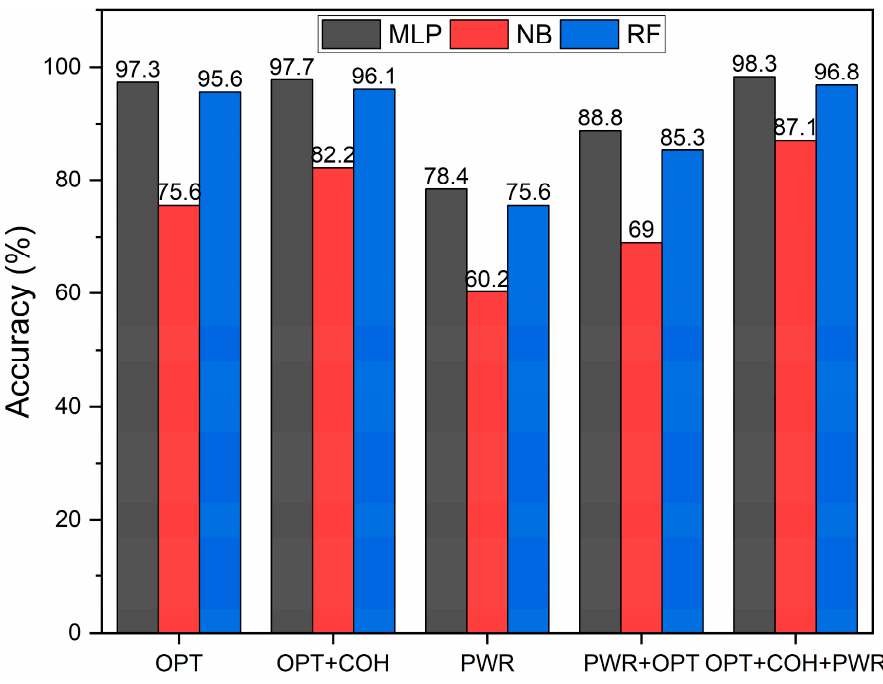
Figure 8. The overall accuracy of three different classification methods (MLP, NB, and RF) on five different datasets (OPT, OPT + COH, PWR, PWR + COH, and OPT + COH + PWR).